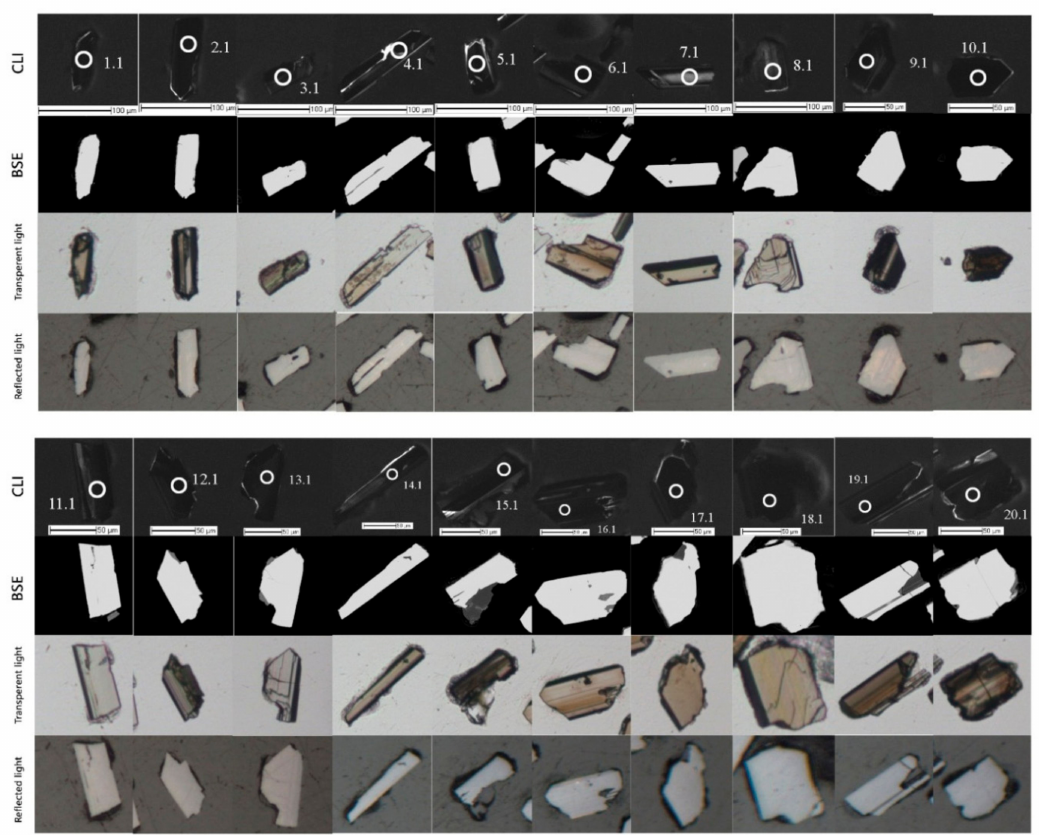
Figure 10. Baddeleyite grains from the trachydolerite sample BT-1 / 114.6. Rows (1–8 from top to bottom): 1 row-grains 1–10 in CLI, 3 row)–grains 1–10 in back-scattered electron (BSE), 3 row–grains 1–10 in transparent light, 4 row–grains 1–10 in reflected light; 5 row–grains 11–20 in CLI, 6 row–grains 11–20 in BSE, 7 row-grains 11–20 in transparent light, 8 row–grains 11–20 in reflected